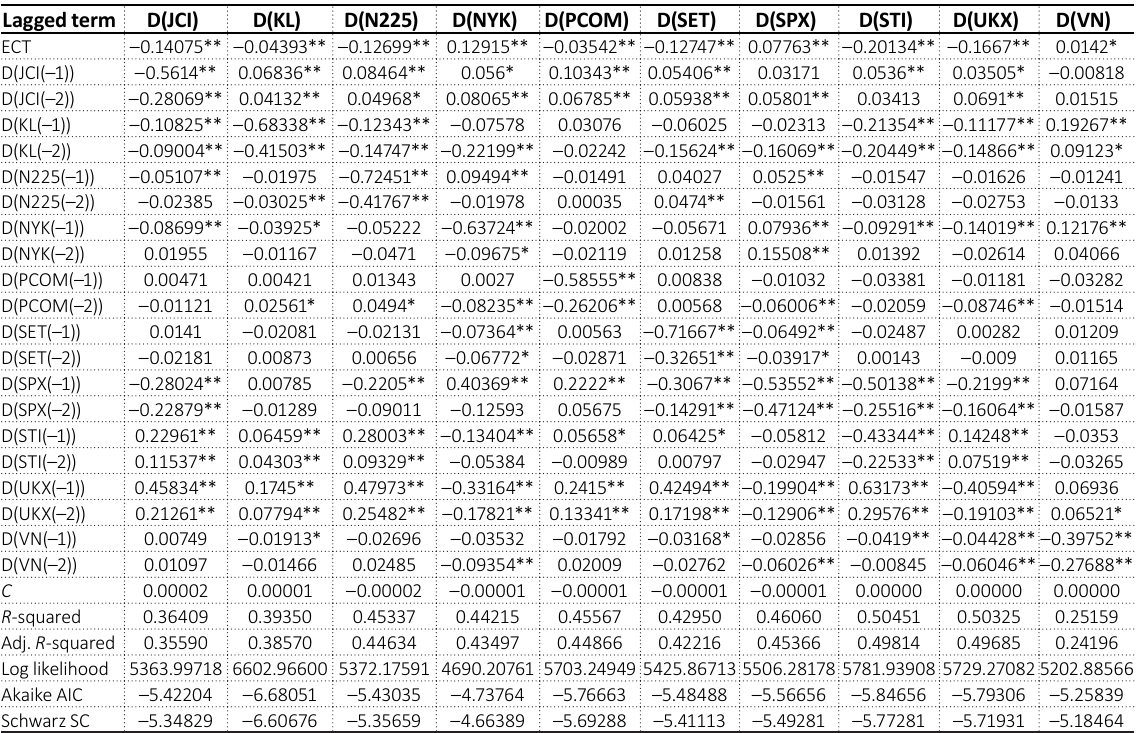
Table 4. Vector error corrections model estimates and